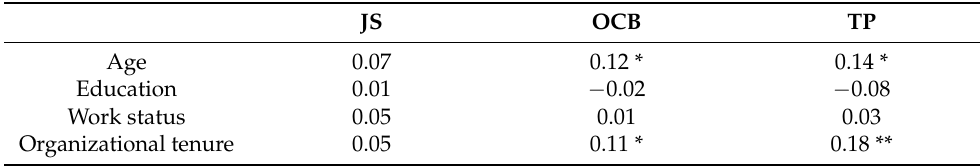
Table 4. Correlations of JS, OCB, and TP with